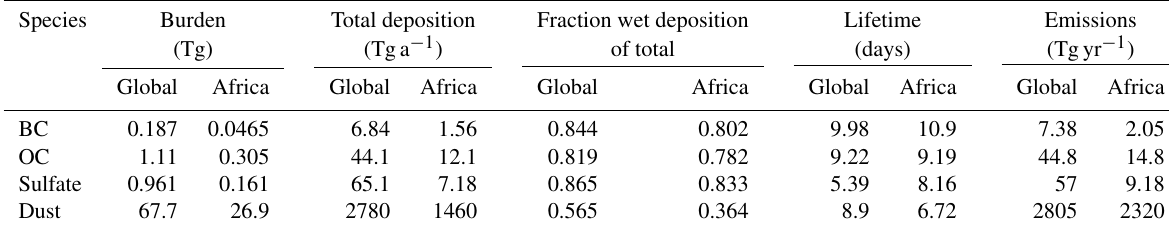
Table 3. Global and Africa-only annual average burdens, lifetimes, total deposition fluxes, and fraction wet deposition of four prognostic aerosol species in CCAM for the year 2010. Species Burden Total deposition Fraction wet deposition Lifetime Emissions (Tg) (Tga − 1 ) of total (days) (Tgyr − 1 ) Global Africa Global Africa Global Africa Global Africa Global Africa BC 0.187 0.0465 Sulfate 0.961